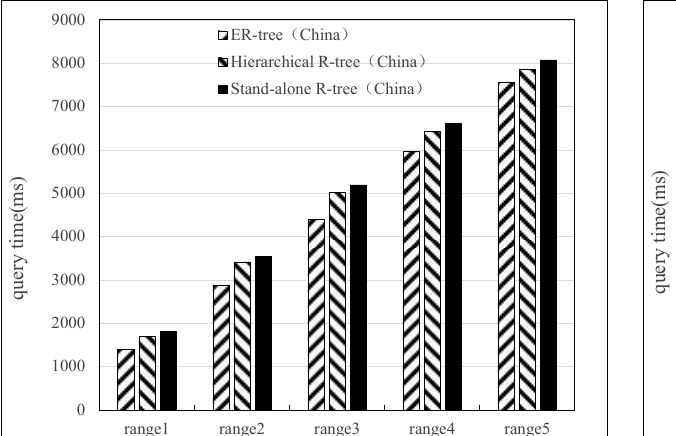
Figure 15. Comparison of the index point query performance on the real dataset. Real dataset range query: Using the centre point of the real dataset to gradually expand the query range outward, this paper conducted five range query operations on the Chinese and New York datasets, respectively and the last query covered all the data points of the real dataset. For example, the approximate centre point of New York is 75° W, 42.5° N, so the first range is from 74° W, 42° N to 76° W, 43° N and the last range is from 70° W, 40° N to 80° W, 45° N, which is roughly the entire range of New York. The experimental results are shown in Figure 16. The ER-tree index has better range query performance regardless of the range of the real dataset, indicating that the index design in this paper is suitable for both short- and large-range queries.